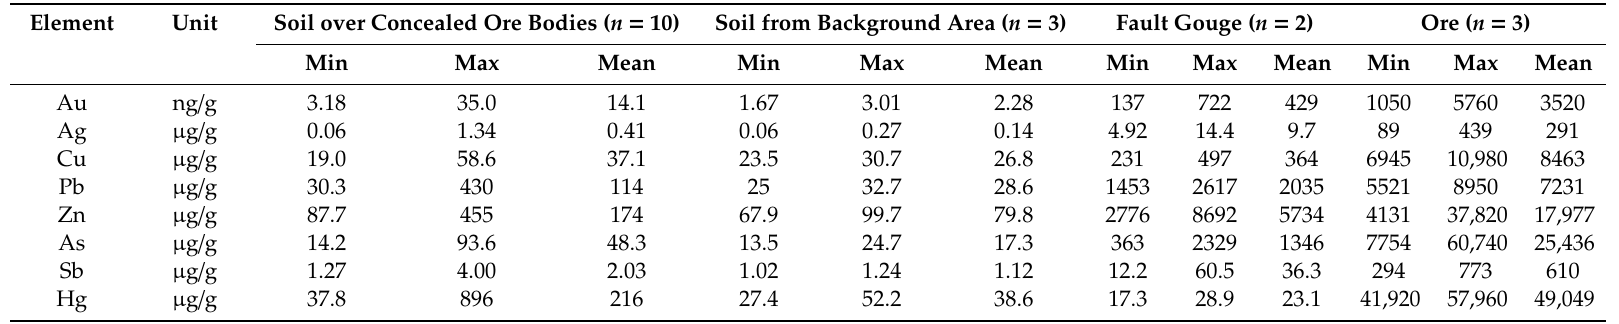
Table 4. Element content of di ff erent solid media from the study